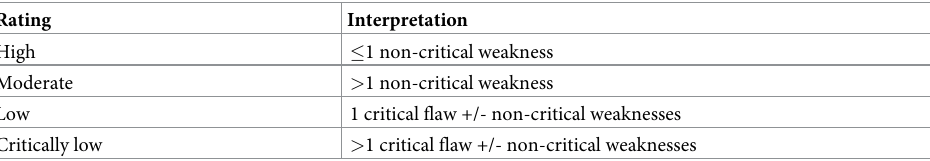
Table 1. AMSTAR-2 overall confidence ratings (from Shea et al.